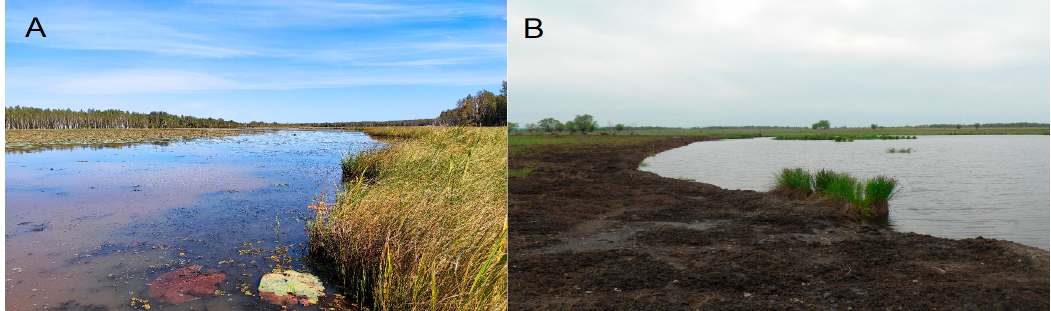
Figure 7. ( A ) Dolgoye Lake in the Bureya floodplain was not washed out by the 2013 flood, by O. Nikitina; ( B ) Lebedinoye Lake in the Amur floodplain was washed out by the 2013 flood of overgrowth, by T. Parilova.